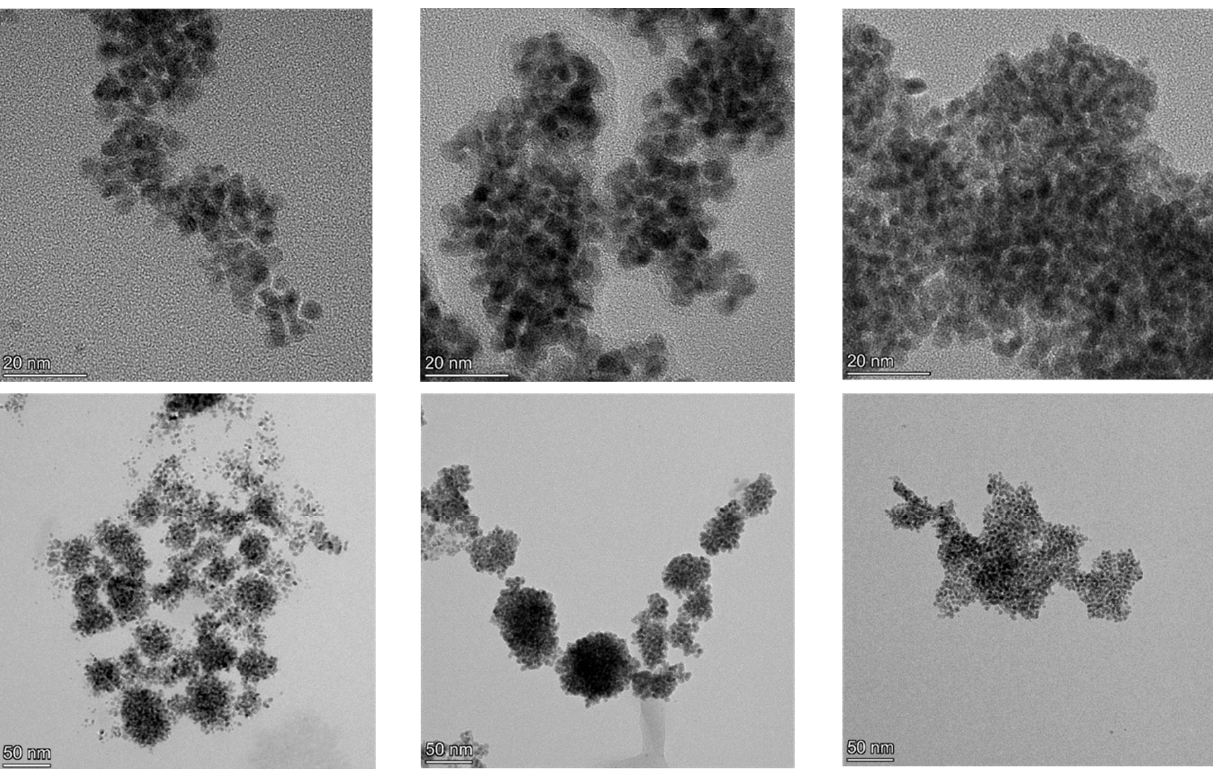
Figure 7. TEM images of i -Pd(OAc) 2 (TPPTS) 2 following oxidation of benzyl alcohol in different alcohols. From left to right: ethanol, 1-propanol, 1-hexanol. Impregnation conditions: i -Pd(OAc) 2 (TPPTS) 2 (10 µmol, Pd), 5 mL alcohol, 60 °C, 1 atm air.